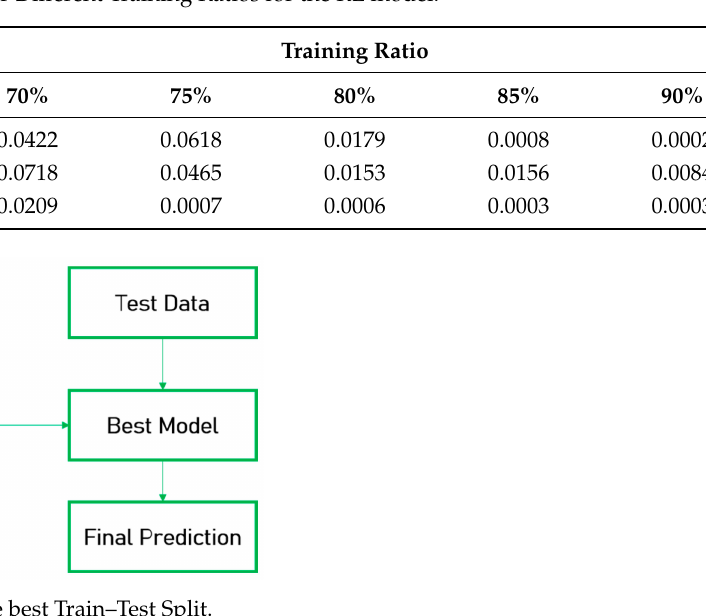
Figure 17. Reward and Loss Function (RL model). Table 4. MSE Value for Different Training Ratios for the RL model.